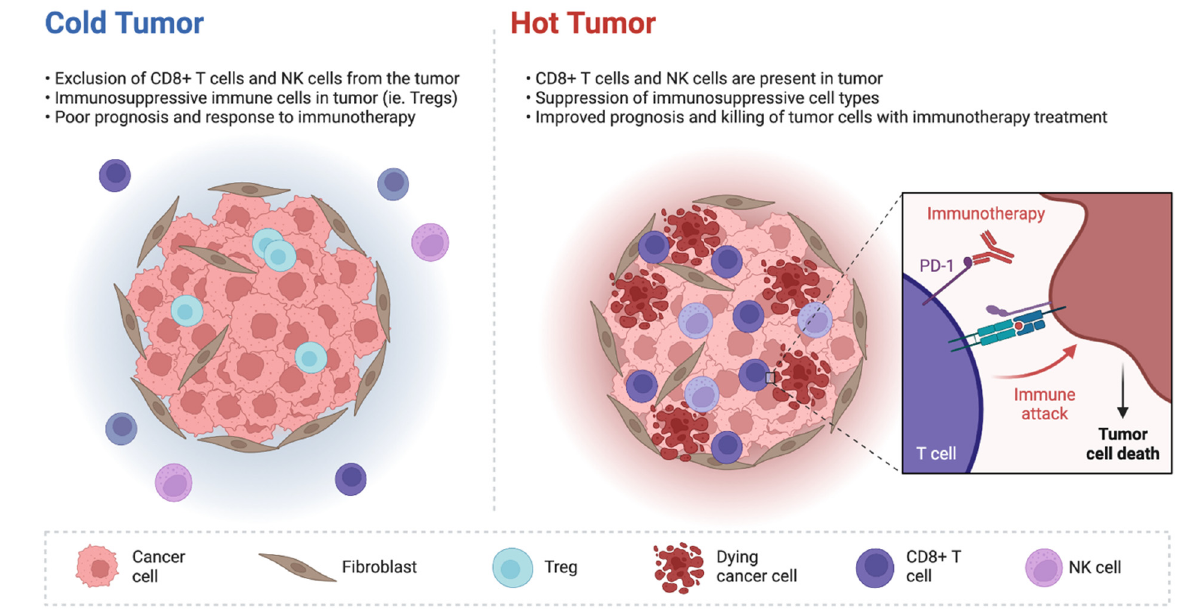
Figure 2. Schematic representation of immunologically “cold” and “hot” tumors.